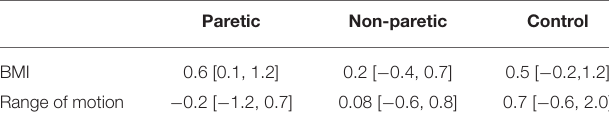
TABLE 2 | Regression coefficient [95% confidence interval] of BMI and range of motion on intramuscular fat fraction in the paretic, non-paretic, and control medial gastrocnemius muscles.